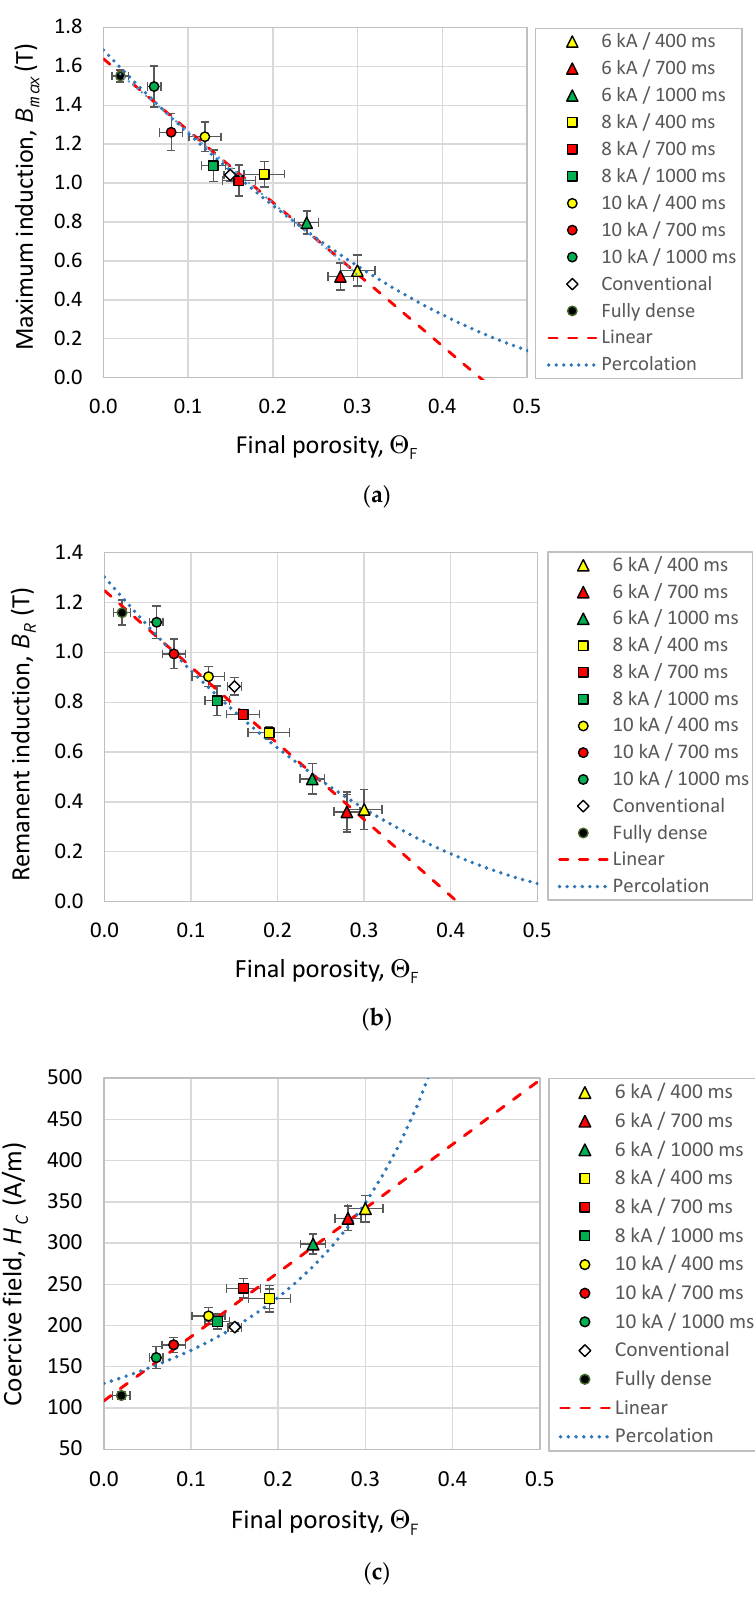
Figure 10. Magnetic properties vs. final porosity ( Θ F ) for the MF-ERS and furnace sintered compacts: ( a ) maximum magnetic induction ( B max ); ( b ) remanent magnetic induction ( B R ); ( c ) coercive field ( H C ). Dashed trend lines are obtained by fitting Equations (5) and